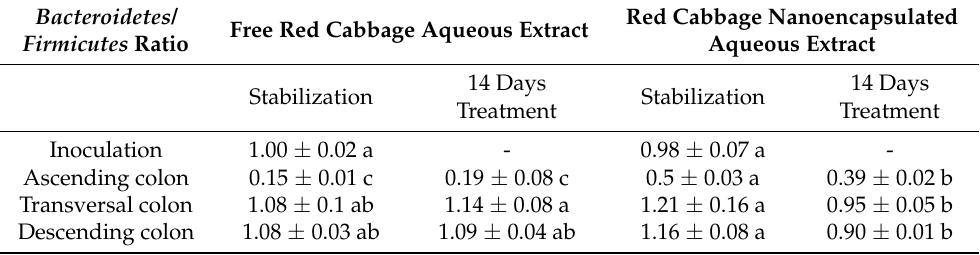
Table 3. Bacteroidetes/Firmicutes ratio obtained in the inoculation time and in the ascending, transver- sal, and descending colon reactors after the feeding with red cabbage aqueous extract (free or nanoencapsulated) for 14 days. The results show n = 3 ± SE. Different letters indicate statistically significant differences in the HSD Tukey’s test, performed after a two-way ANOVA ( p <